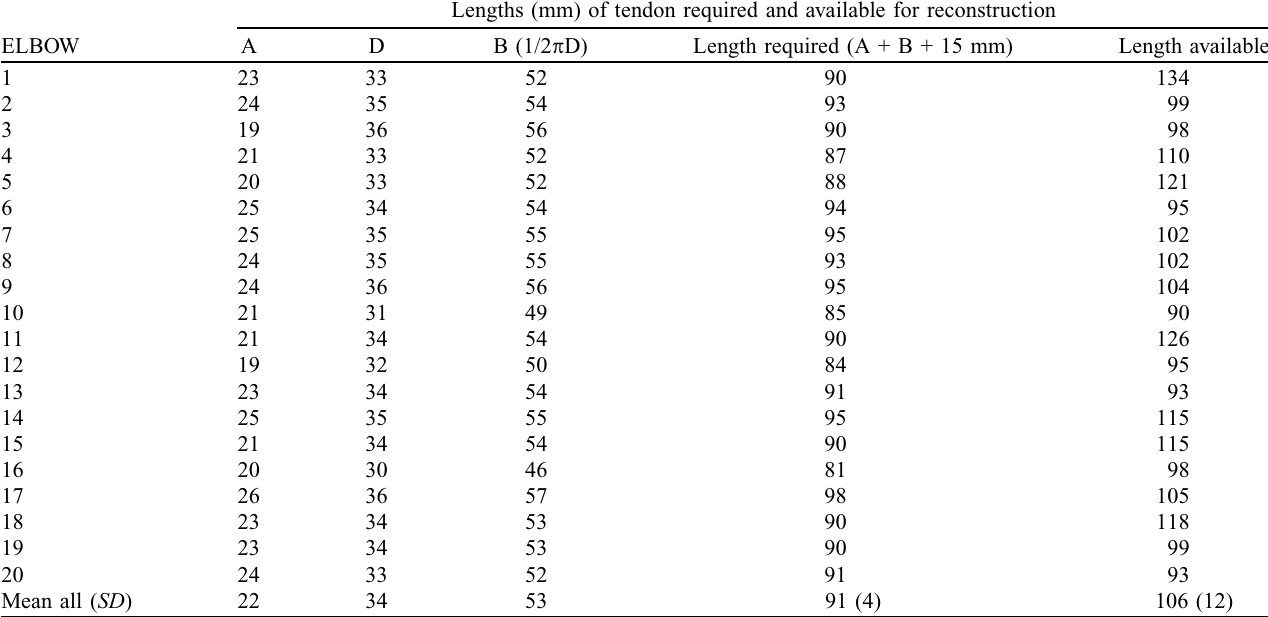
Table 1. Lengths of triceps tendon required and available in 20 cadaveric elbows.